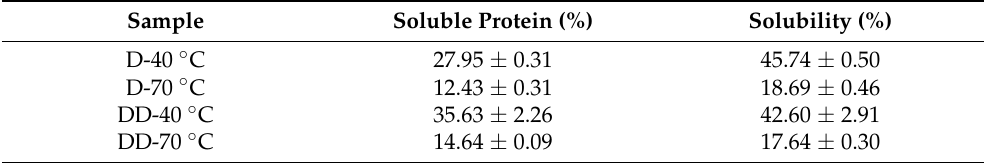
Table 5. Soluble protein (%) and protein solubility (soluble protein/total protein, %) of porcine